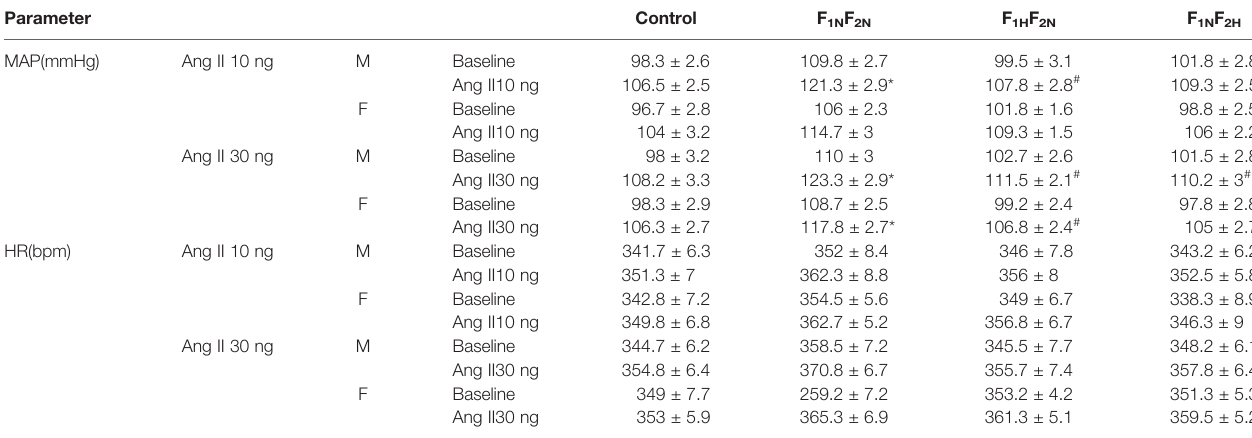
TABLE 2 | Basal MAP and HR were measured under anaesthesia with a pressure transducer through a catheter placed in the left femoral artery.